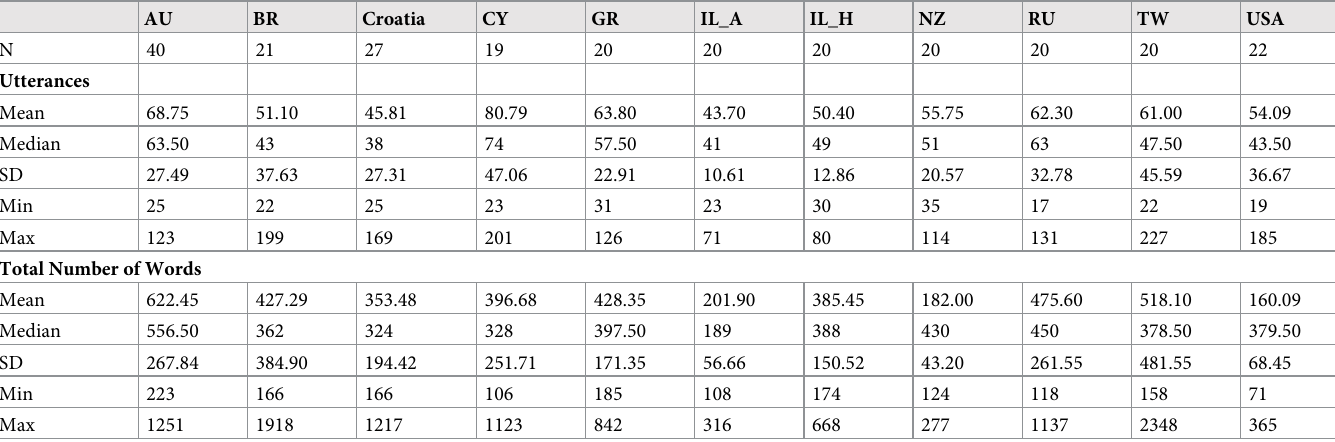
Table 2. Performance by country on measures of productivity.